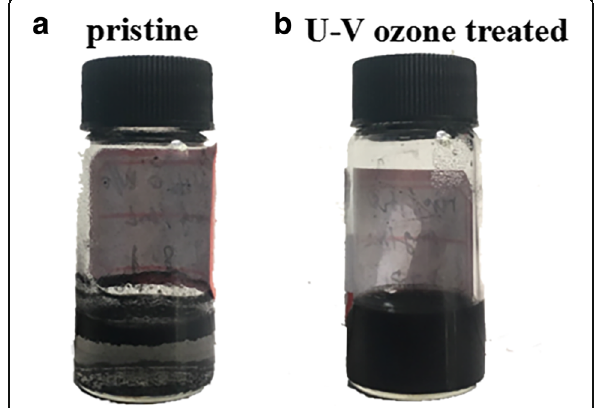
Fig. 1 Photographs of a untreated and b UV-ozone-treated rGO solution (1 mg/mL in H 2 O)